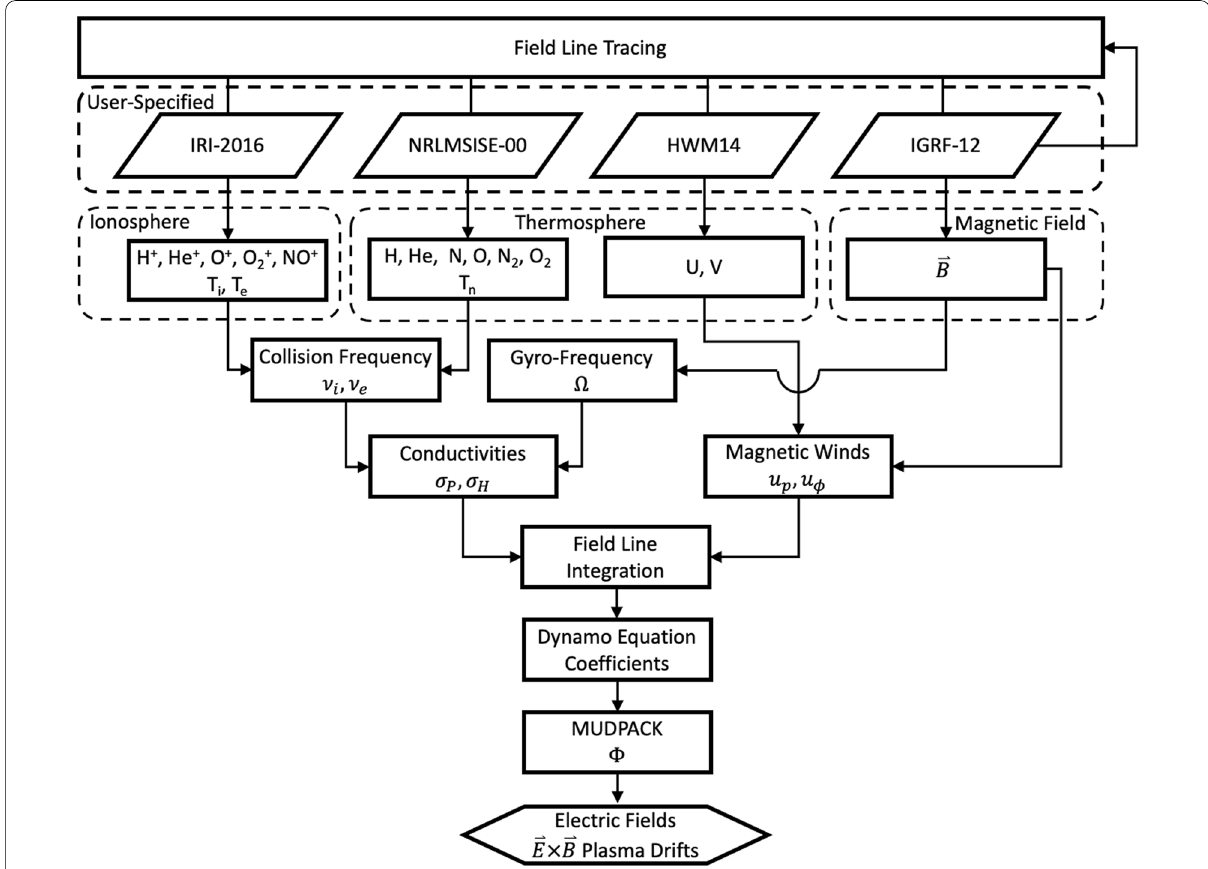
Fig. 1 Block diagram showing the components of the DINAMO